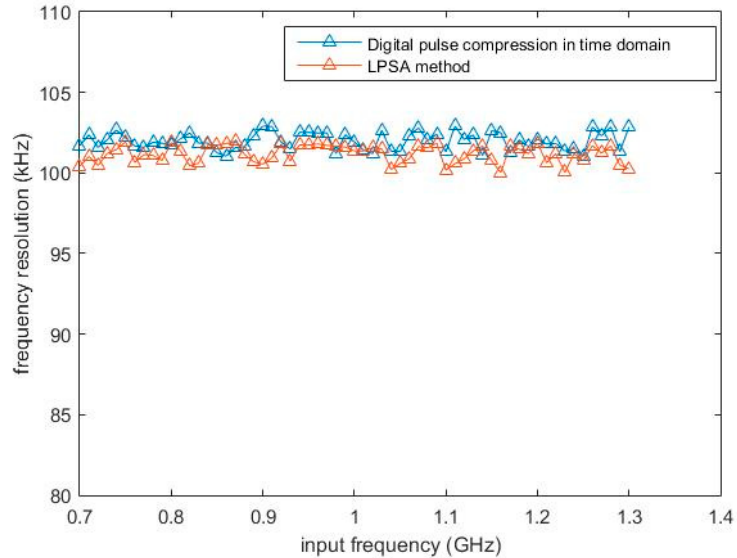
Figure 11. Frequency resolutions obtained by the LPSA algorithm and the classical time-domain pulse compression method.